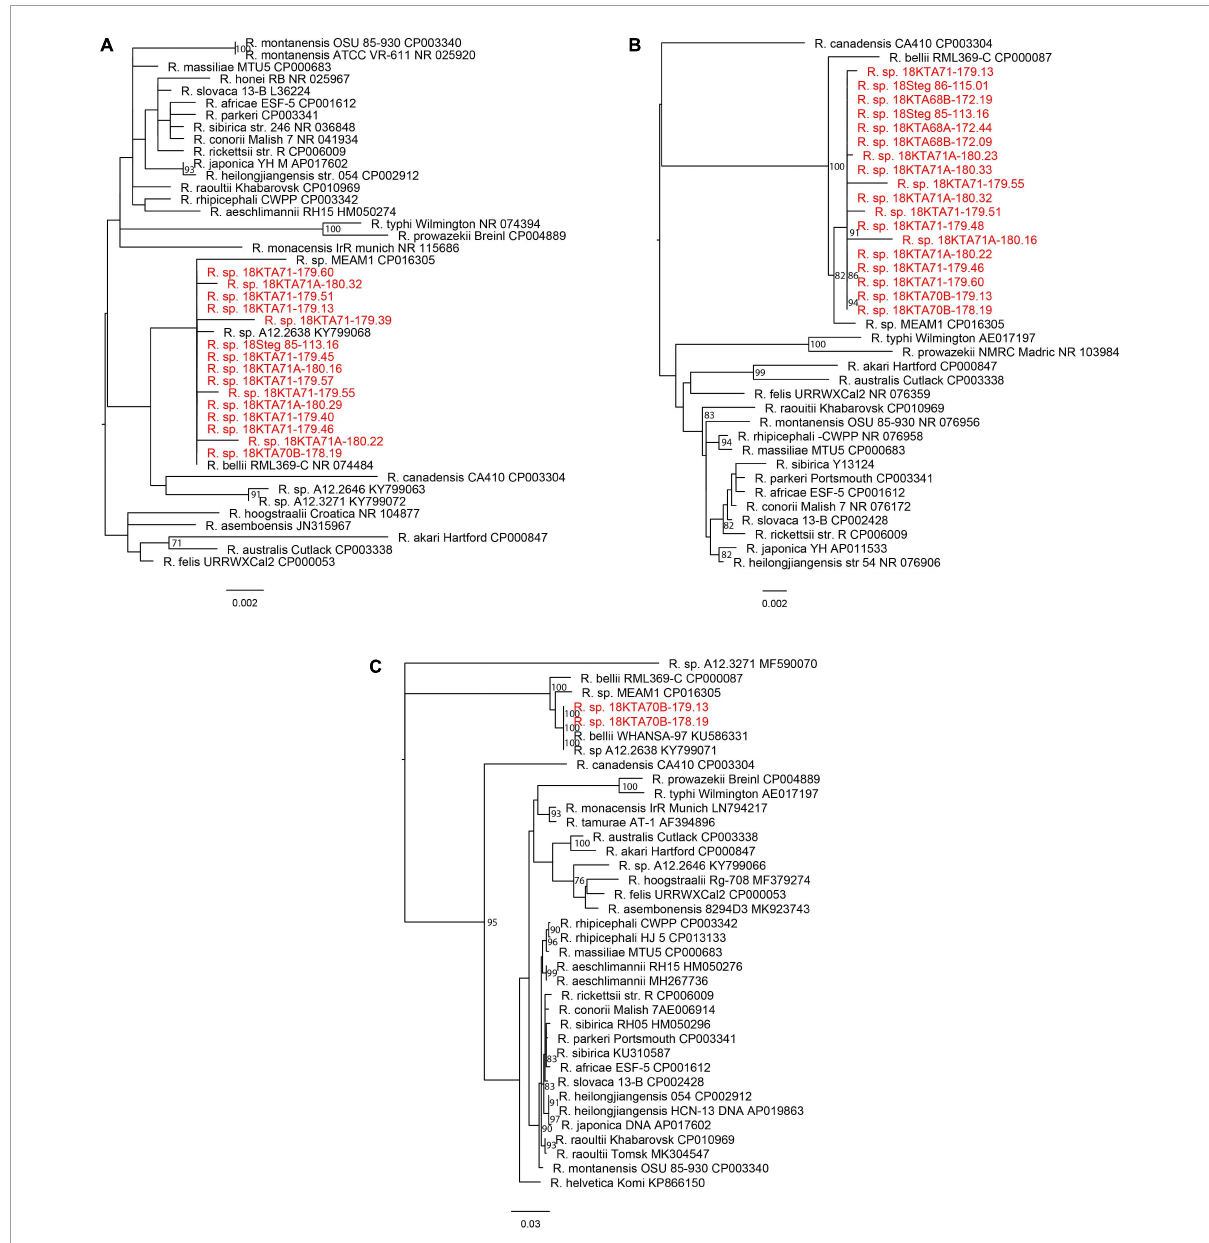
FIGURE2 Phylogeny of Rickettsia sp. from this study and known rickettsial strains. (A) 16S rRNA gene; (B) 23S rRNA gene; and (C) gltA gene. The maximum likelihood phylogenetic tree with bootstrap support values from 1,000 replicates is shown at the branches. The scale bar represents estimated nucleotide substitutions per site. The sequences from this study are shown in